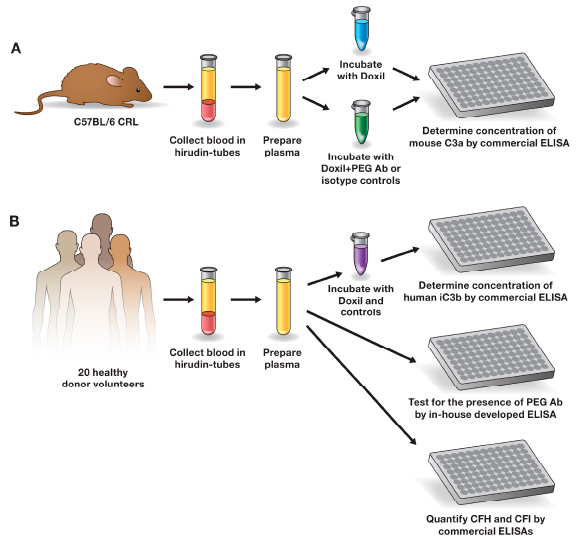
Figure 1. Study design. ( A ) The role of well-characterized mouse antibody in the complement activation by Doxil in mouse plasma; ( B ) detecting and understanding the role of pre-existing anti-PEG antibodies in the complement activation by Doxil in human plasma. Ab—antibody;